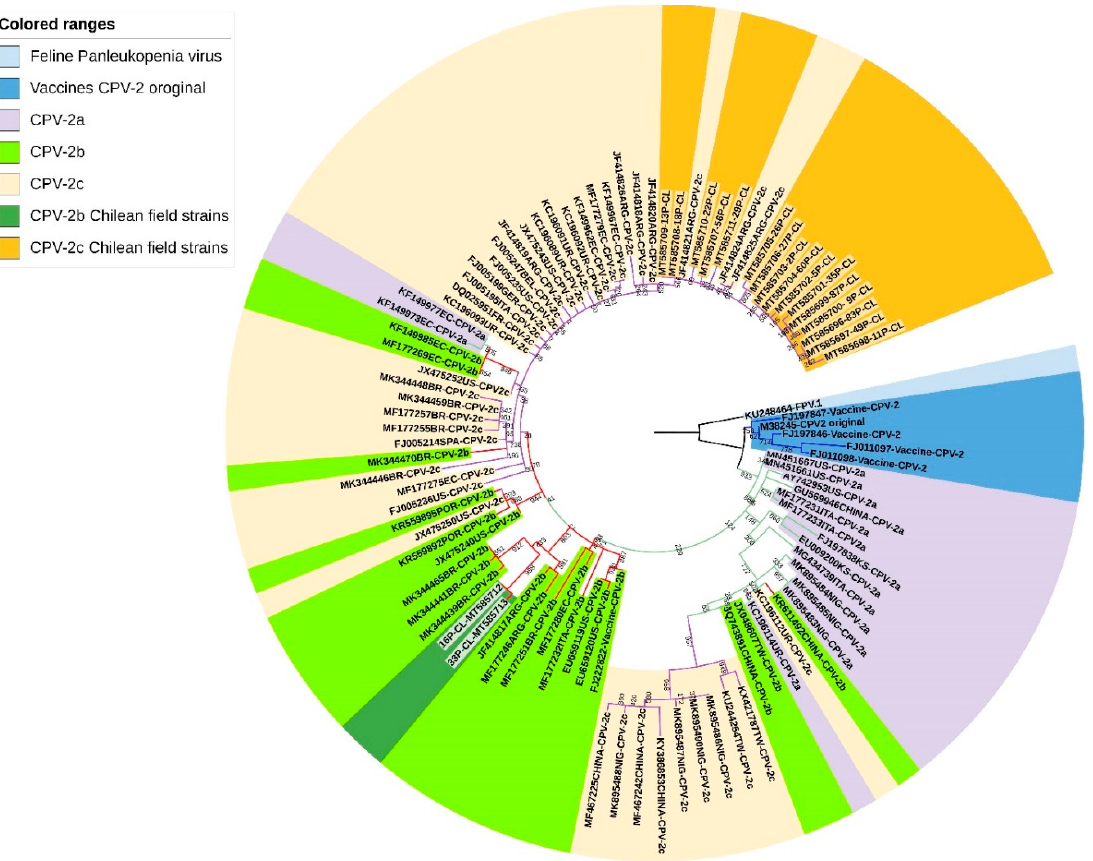
Figure 1. Phylogenetic tree using the maximum likelihood (ML) method. Phylogenetic inferences were carried out using complete nucleotide sequences of the VP2 gene of CPV-2a, CPV-2b and CPV-2c, including different countries in Europe (GER: Germany; ITA: Italy; SPA: Spain; FRA: France; BEL: Belgium; and POR: Portugal), Asia (CHINA; TW: Taiwan; and KS: